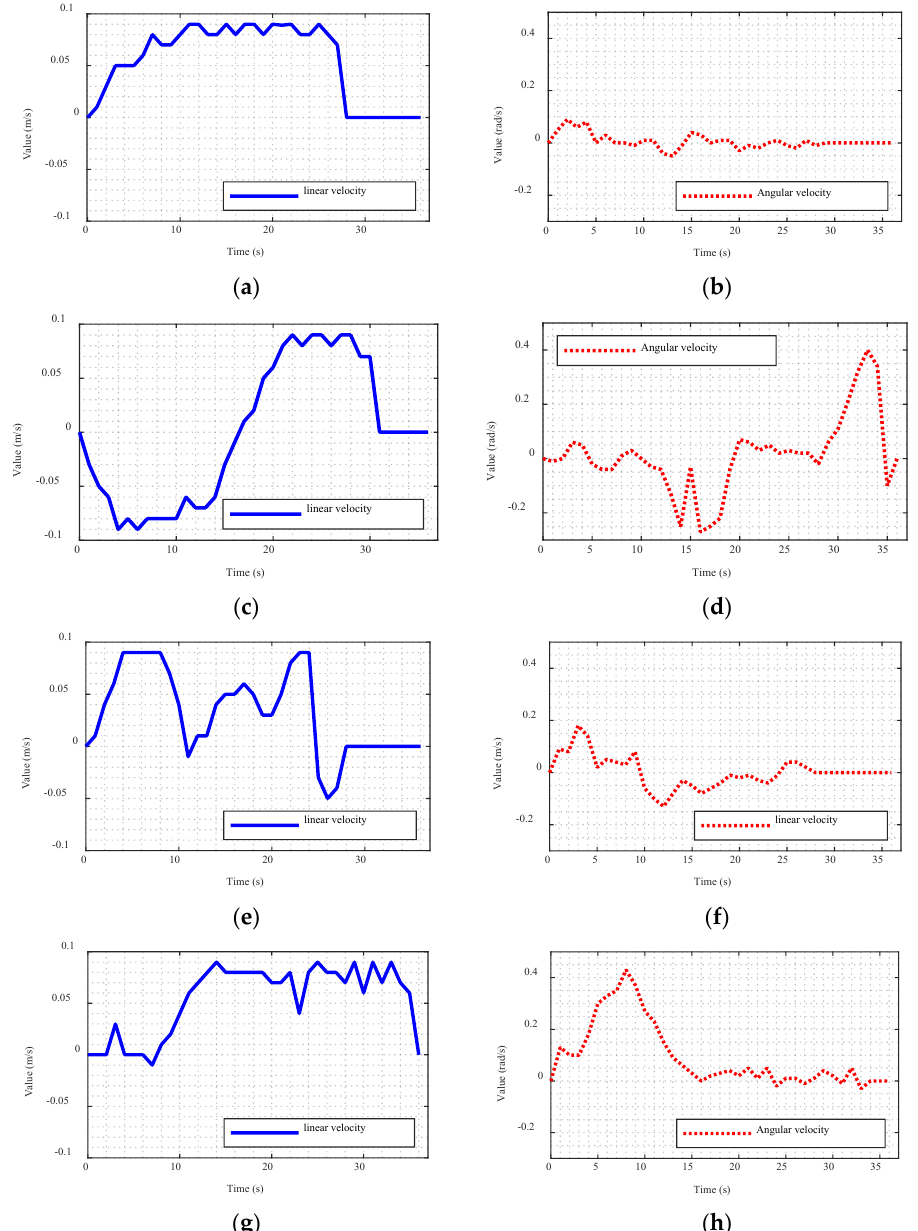
Figure 15. Linear and angular velocity change curves of Owlbot in four navigation tests: ( a , b ) Case 1; ( c , d ) Case 2; ( e , f ) Case 3; ( g , h ) Case 4.